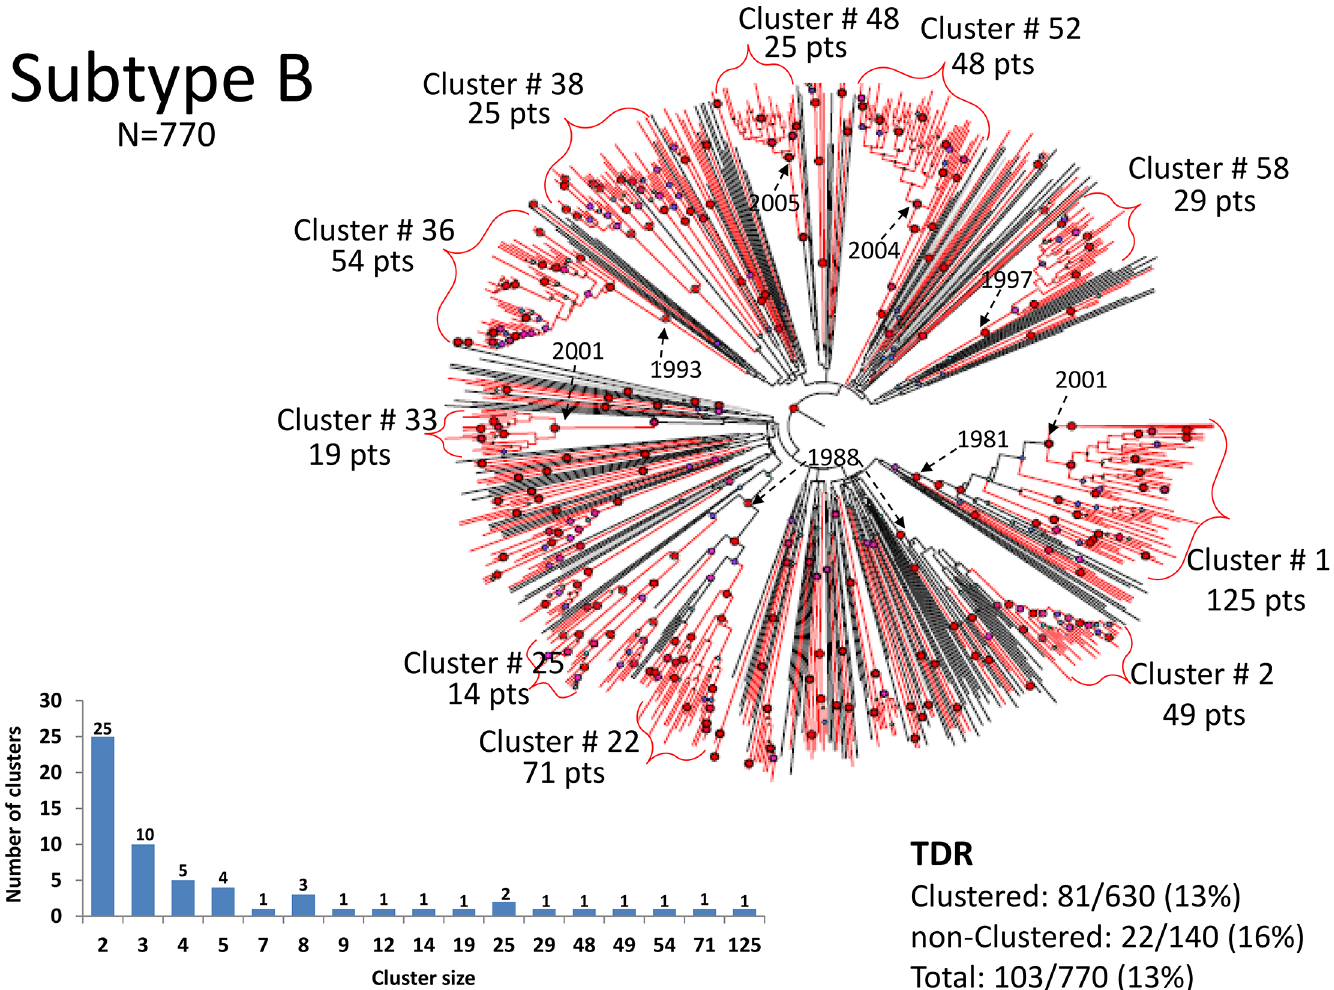
Fig 4. BEAST of subtype B. Analysis of sequences from patients infected with subtype B (Including 30 reference sequences). Notations as in Fig 2.